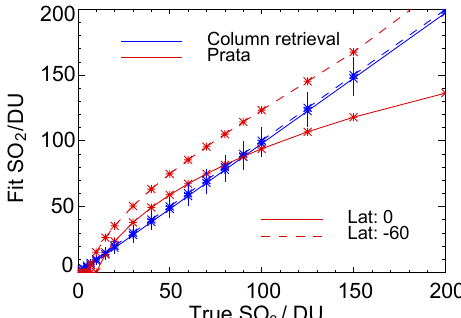
Figure 2. Retrievals based on simulations by a line-by-line model (RFM), with synthetic measurement noise. The error bars for the column retrieval are the retrieved errors. These simulations use tem- perature and water vapour from a cloud-free ECMWF ERA-Interim atmosphere on 15 August 1991, for a grid box centred at 0 ◦ N and − 60 ◦ N latitude and 0 ◦ E longitude. The vertical bars show the re- trieved error for the column retrieval. No error estimates are possi- ble for the Prata fit